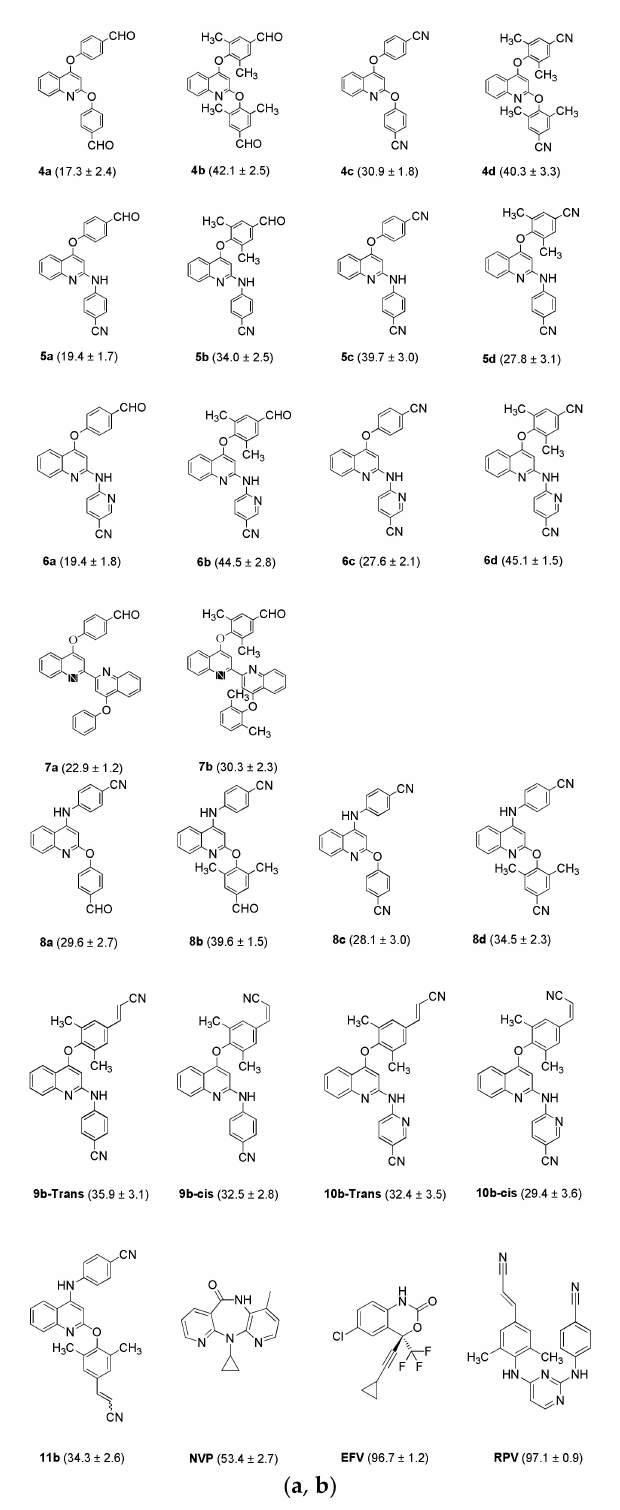
Figure 1. Inhibitory activities (%) of the derivatives and commercially available drugs at 1 µ M against HIV-1 RTa. ( a ) The RT kit was commercially available and supplied by Roche, and the data were obtained by standard ELISA. ( b ) Results are expressed as the mean ± standard error of inhibitory activity